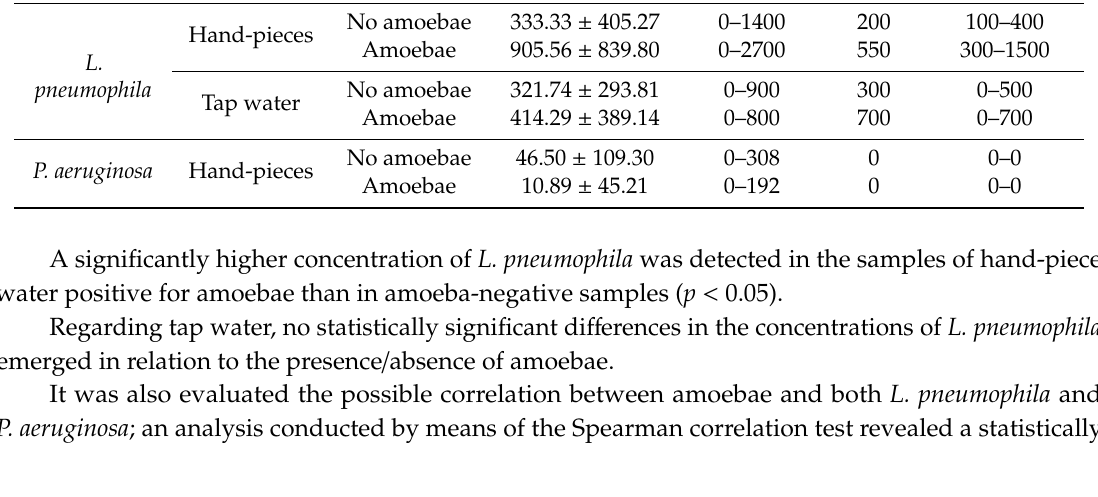
Table 2. Concentrations of L. pneumophila (CFU / L) and P. aeruginosa (CFU / 100 mL) in the presence and absence of amoebae.